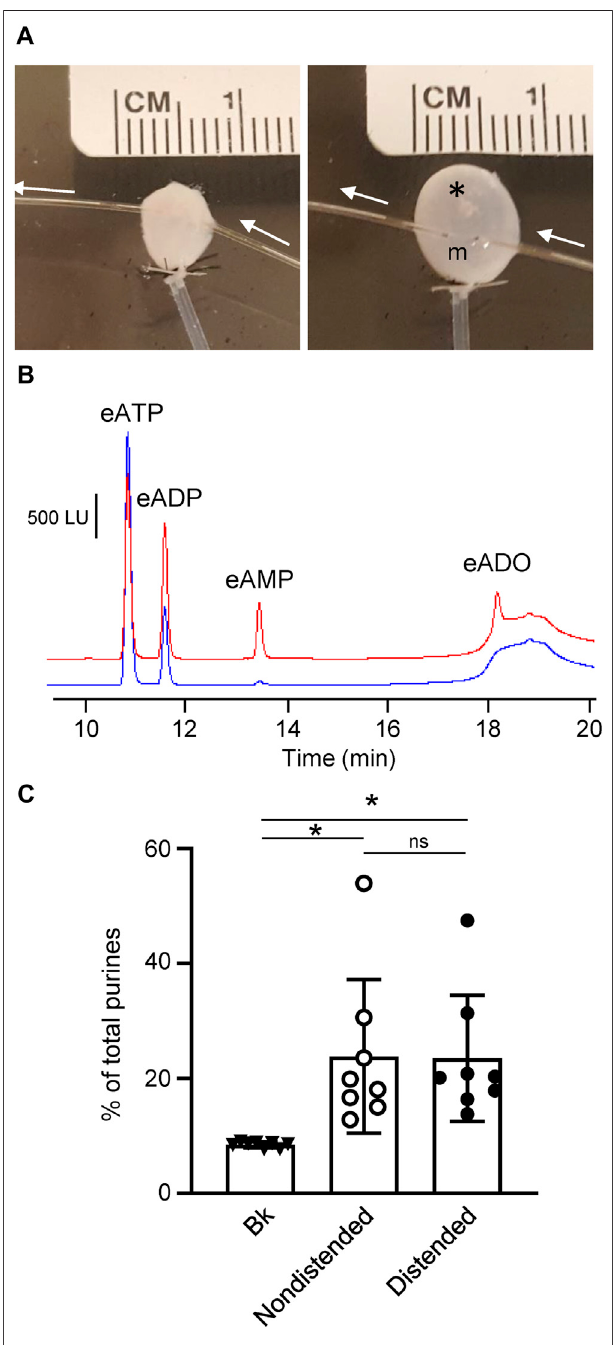
FIGURE 4 | Degradation of eATP in the suburothelium evaluated by microdialysis of the bladder wall. (A) Microdialysis probe implanted between suburothelium/LP and detrusor muscle of nondistended (left panel) and distended (right panel) mouse urinary bladder. m, microdialysis membrane outlined with black dots; white arrows show the direction of microdialysis perfusion. *, air bubbles inserted in bladder to show transparency of the wall. (B) Original chromatograms of eATP substrate in absence of tissue (beaker and blue) and in dialysate from nondistended bladder (red). Addition of eATP in the solution perfusing the microdialysis probe resulted in an eADP increase and the appearance of eAMP and eADO.